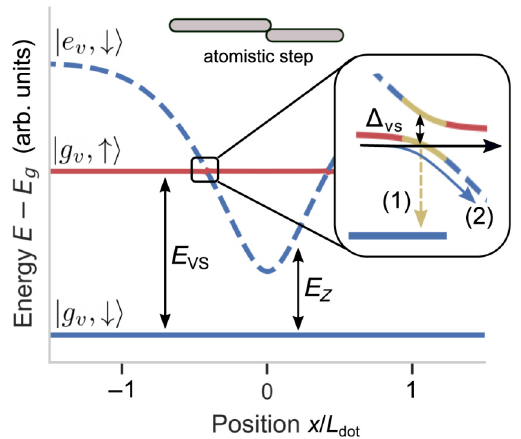
FIG. 14. Sketch of energy difference between the following states: ground valley spin-up state | g v , ↑(cid:7) , excited valley spin- down state | e v , ↓(cid:7) , and the lowest-lying level | g v , ↓(cid:7) with energy E g at the spin-valley hotspot caused by the atomistic step. Inset: enlargement of the avoided crossing between | e v , ↓(cid:7) and | g v , ↑(cid:7) states, where we identify two mechanisms responsible for the spin-flip error δ p ↑ : (1) the relaxation in vicinity of avoided cross- ing, due to hybridization between spin and valley states (yellow arrow) and (2) adiabatic transition that converts spin up to spin down, followed by subsequent relaxation, dephasing, and possi- bly more nonadiabatic transitions at the subsequent level crossing (blue arrow). For illustration purposes we use arbitrary